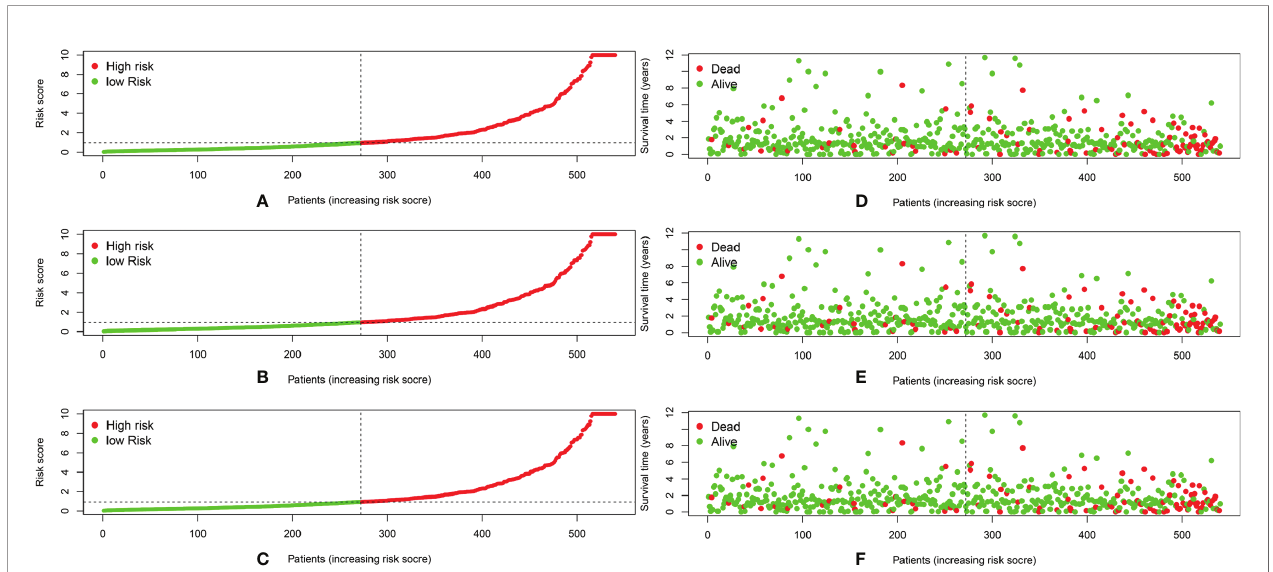
FIGURE 4 | (A – C) The distribution of the risk scores of the patients in both high- and low-risk score groups among train set, validation set, and all patients. (D – F) Patients ’ survival status and time distributed by risk score among train set, validation set, and all